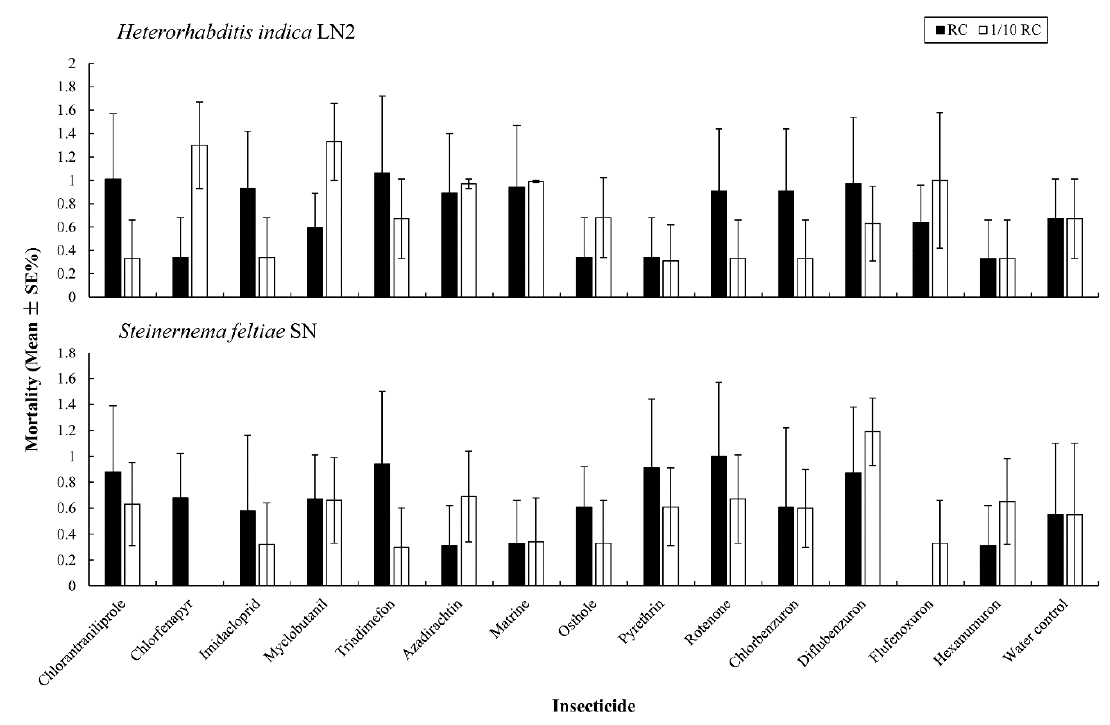
Figure 1. Mortality rates of Steinernema feltiae SN and Heterorhabditis indica LN2, 72 h after exposure to different insecticides at the recommended field concentration (RC) and 1/10 RC. The bars do not differ significantly at the same insecticide concentration ( p > 0.05, Tukey’s test).